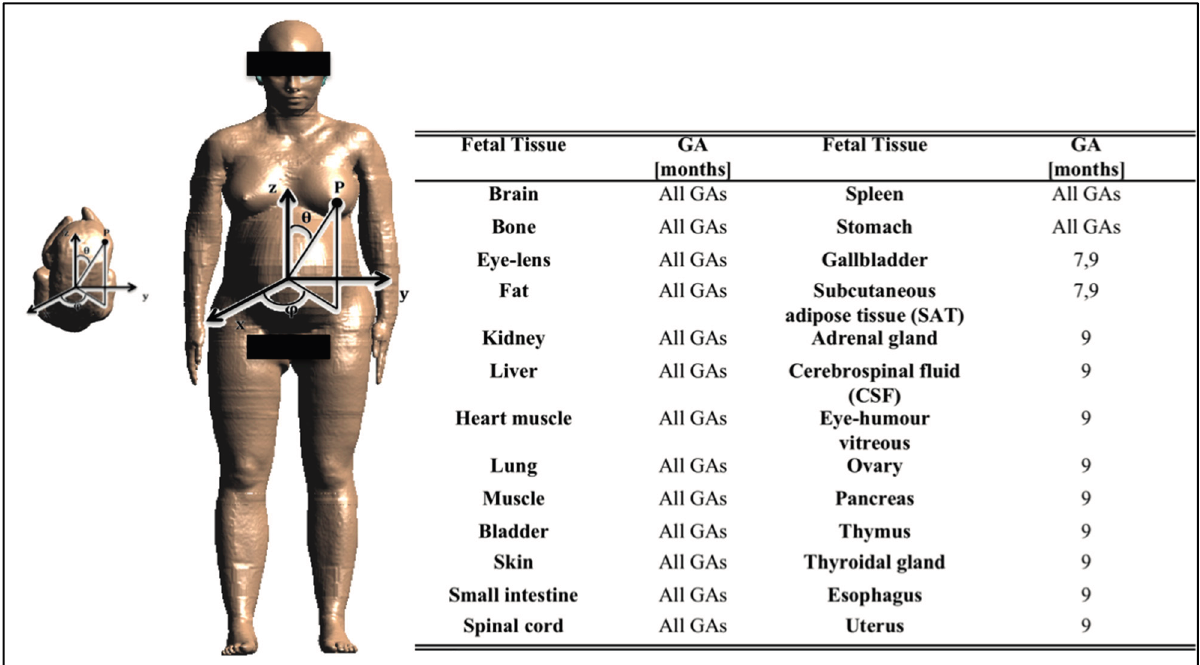
Figure 2. On the left: pregnant woman model at 9 months gestational age (GA) with the Cartesian reference system x,y,z and the spherical coordinates θ , φ . The fetus image is also reported to present its position in the pregnant woman’s womb. On the right: table with the fetal tissues at each